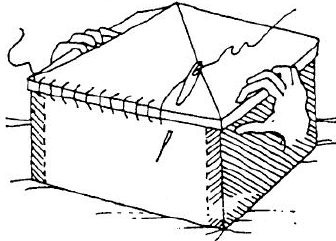
Figure 6. The effectiveness of structural connections provides box-type behavior to the building. Figure 6. The e ff ectiveness of structural connections provides box-type behavior to the